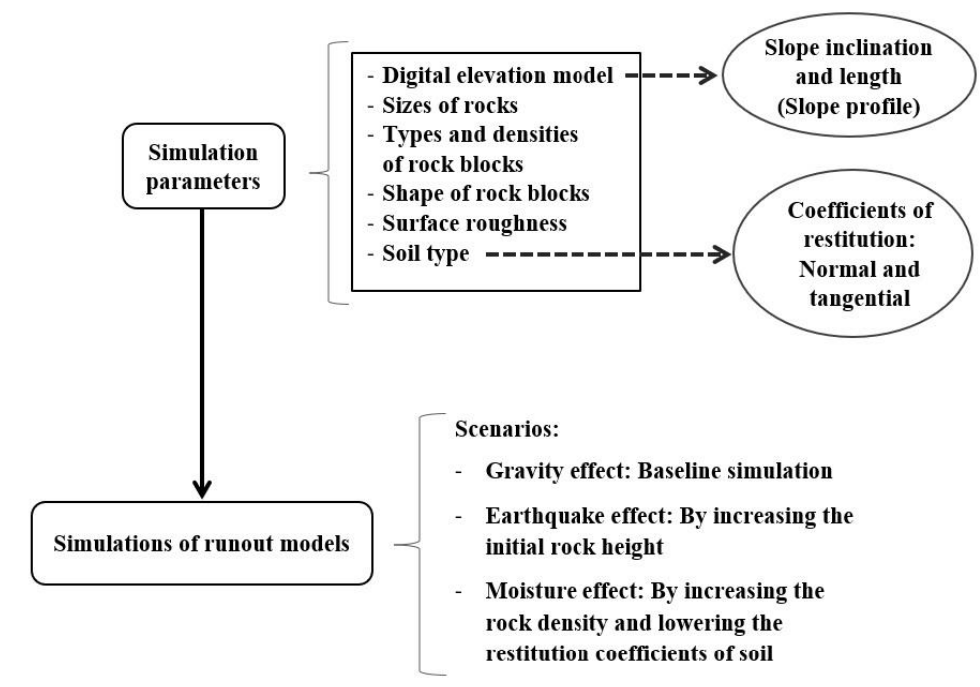
Figure 8. Simulations’ process.